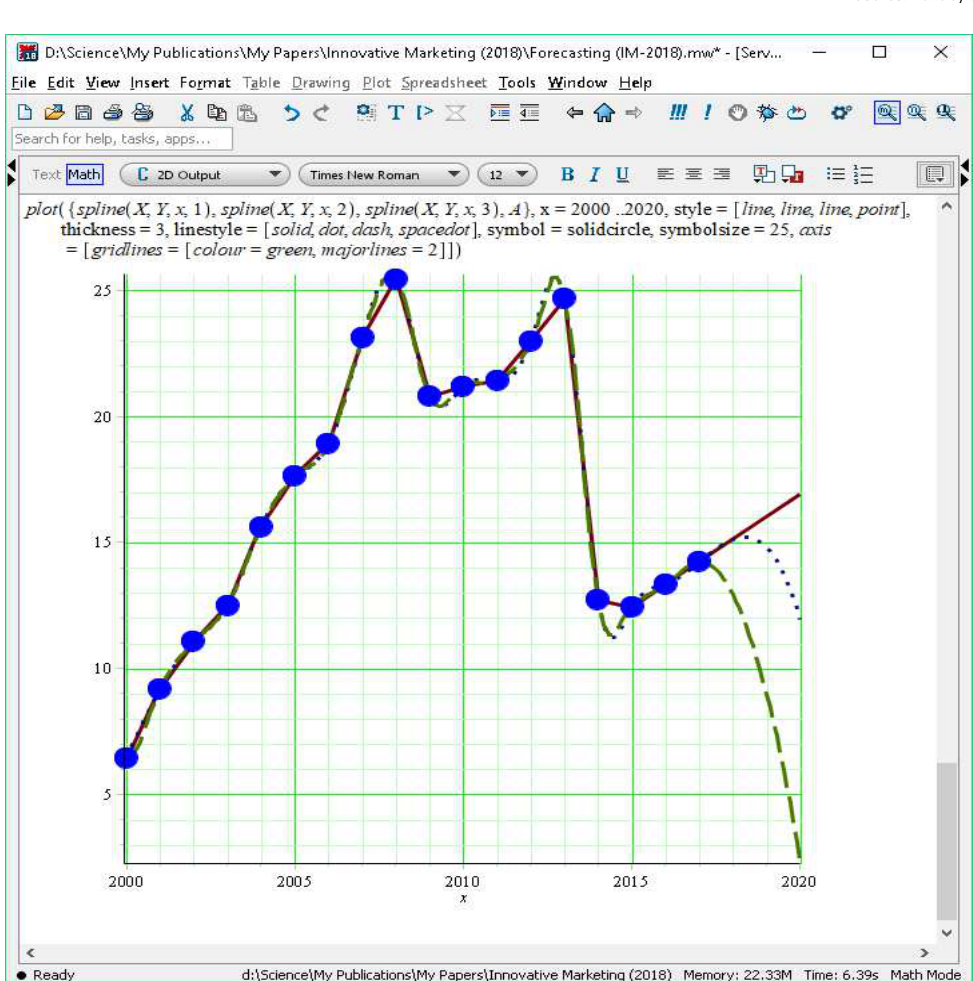
Figure 4. Visualization of forecasting models by